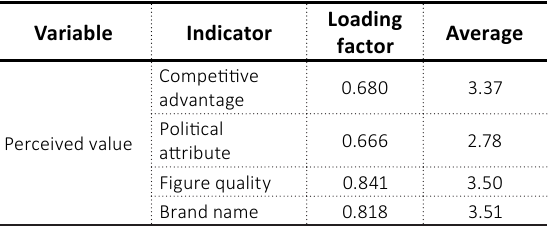
Table 2. The results of evaluation of outer model for perceived value